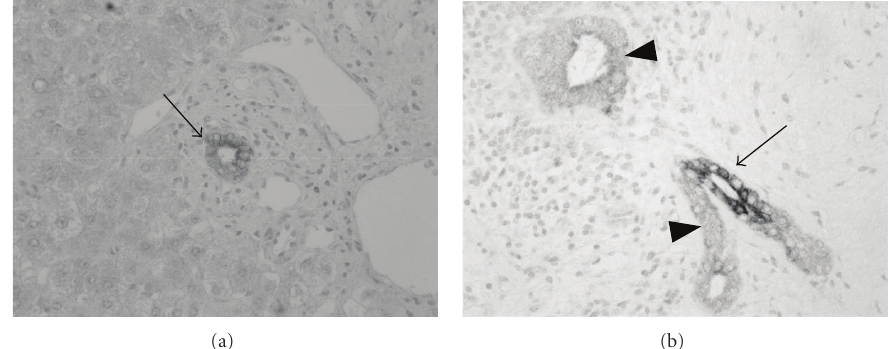
Figure 5: Immunohistochemistry for peroxisome proliferator-activated receptor γ (PPAR γ ). (a) Normal liver. PPAR γ is expressed in the cytoplasm of bile ducts (arrow). (b) Primary biliary cirrhosis (PBC). Damaged bile ducts (arrowhead) show reduced expression of PPAR γ , though evidently positive biliary cells (arrow) also remain.